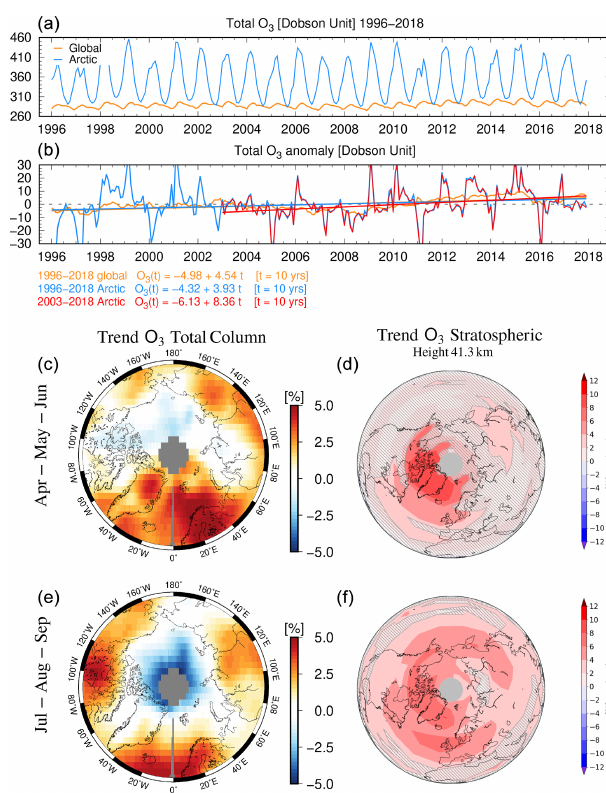
Figure F1. (a, b) Global and Arctic record of total ozone with the respective anomalies and trends. The Arctic time series has been ad- ditionally shortened to match the length of the stratospheric ozone column. (c–f) Trends (% per decade) of total (c, e) and strato- spheric (d, f) ozone between 2003 and 2018 are plotted for spring (AMJ) and summer (JAS)